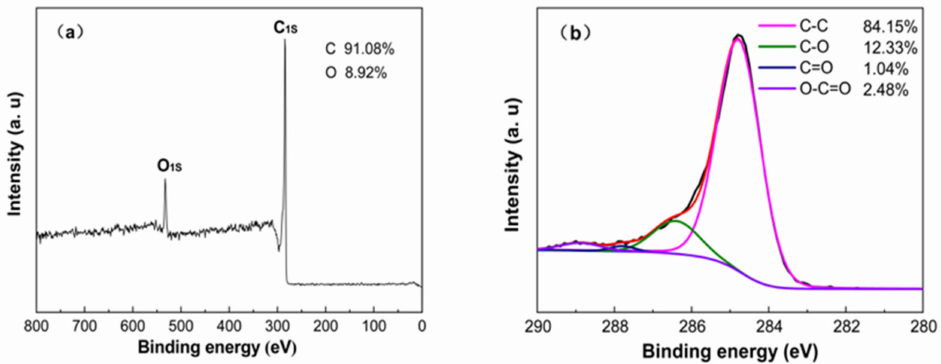
Figure 5. ( a ) XPS survey; ( b ) high-resolution spectra of C1s for